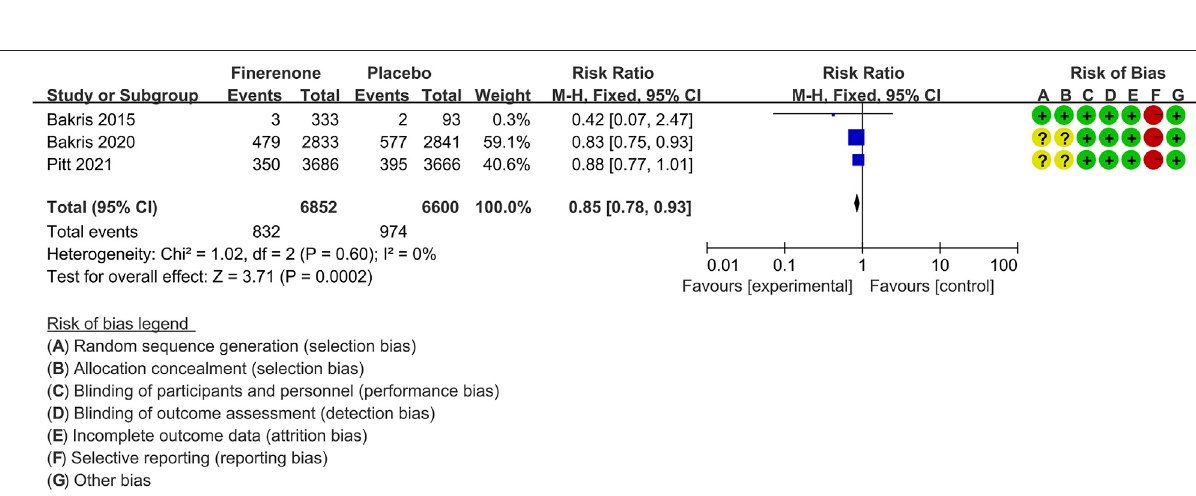
FIGURE 4 | Meta-analysis results of changes in the eGFR from the baseline for fi nerenone and placebo patient groups.